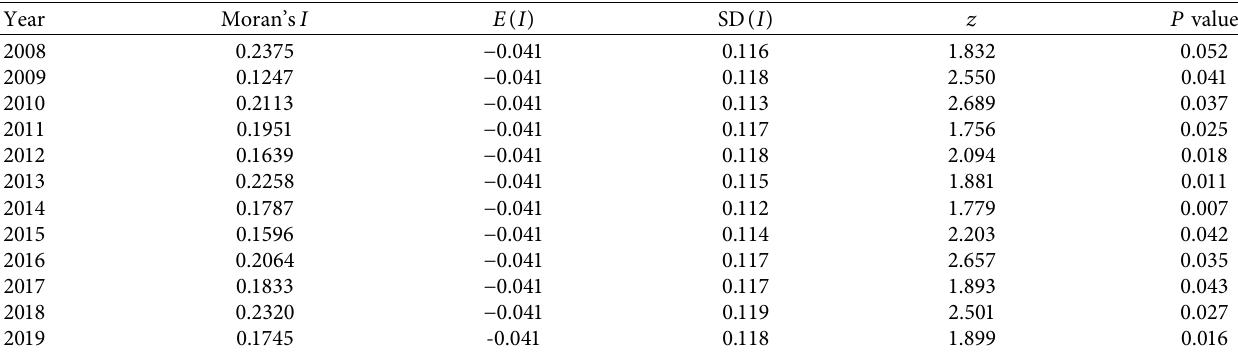
Table 3: Global Moran’s I statistical indicators of energy utilization in 31 provinces of China from 2008 to 2019.